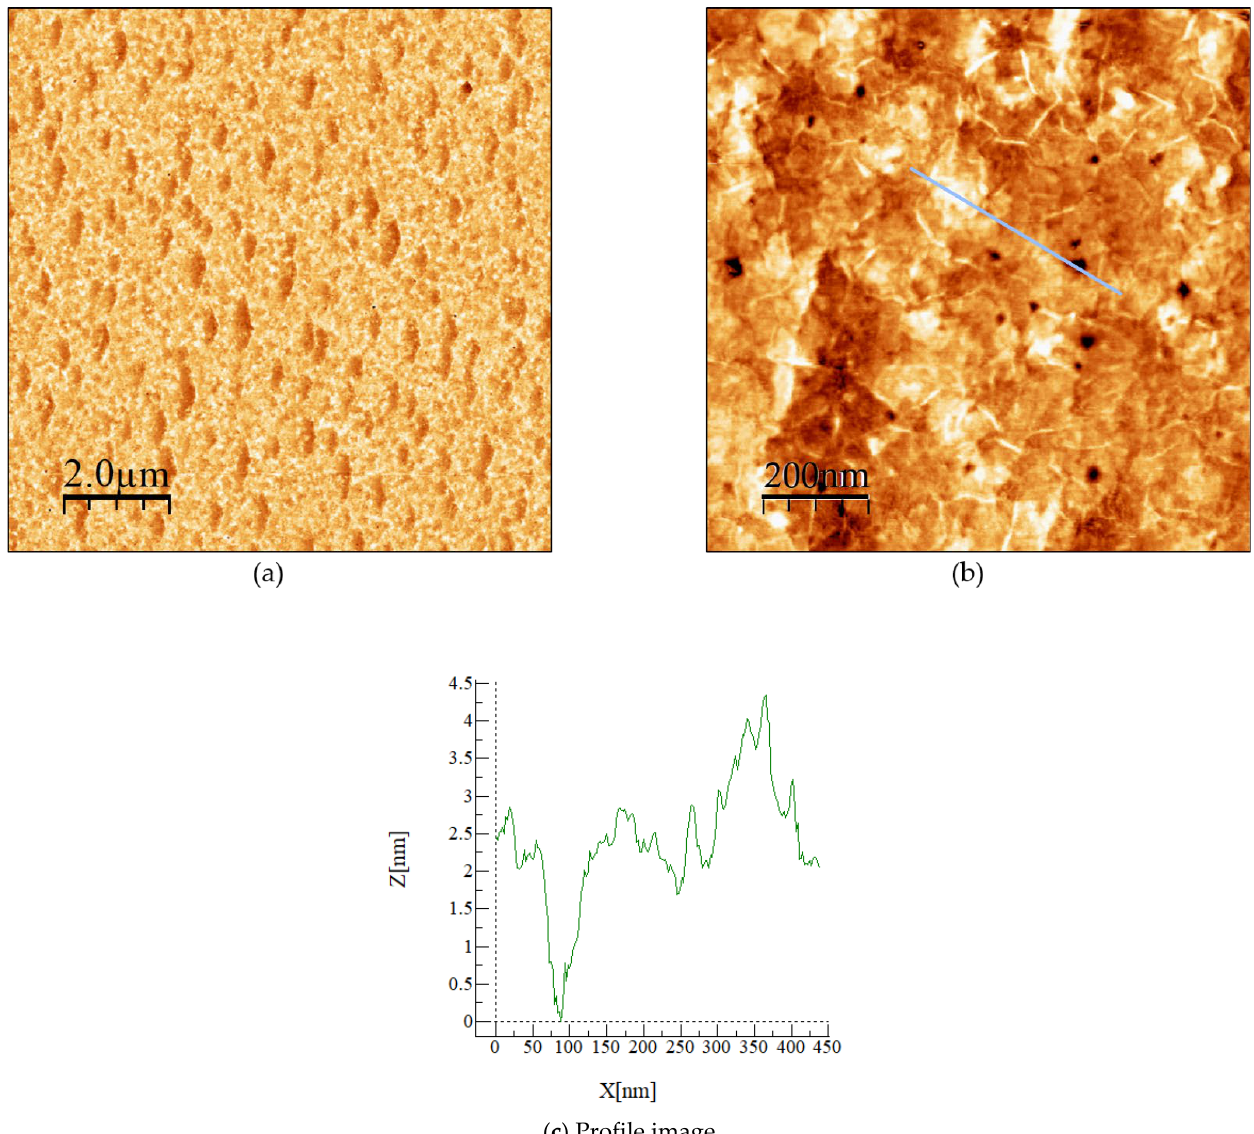
Figure 1. Atomic force microscopy images of 3 nm h-BN epilayer grown on sapphire c-plane substrate. ( a ) (10 × 10) µm 2 image with an RMS = 0.7 nm, ( b ) (1 × 1) µm 2 image with an RMS = 0.5 nm, and ( c ) profile measurement of a specific marked zone indicated by a blue line in ( b ).